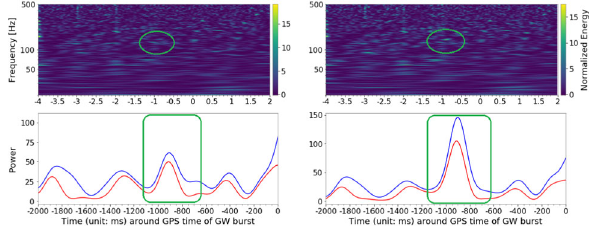
Fig. 4 The left-hand (left panels) and right-hand (right panels) polar- izationsofGWeventGW170817.TimesareshownrelativetoGPStime 1187008882.43.Upperpanelsshowthetime-frequencyrepresentations, and lower panels show the arrive times (unit: ms), where we combine the signal during (135,145)Hz for blue curves and (140,145)Hz for red